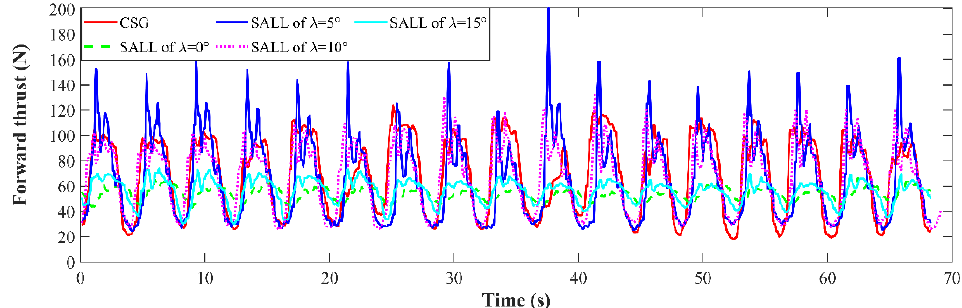
Figure 23. The forward thrusts of the conventional submerged glider and SALL submerged glider